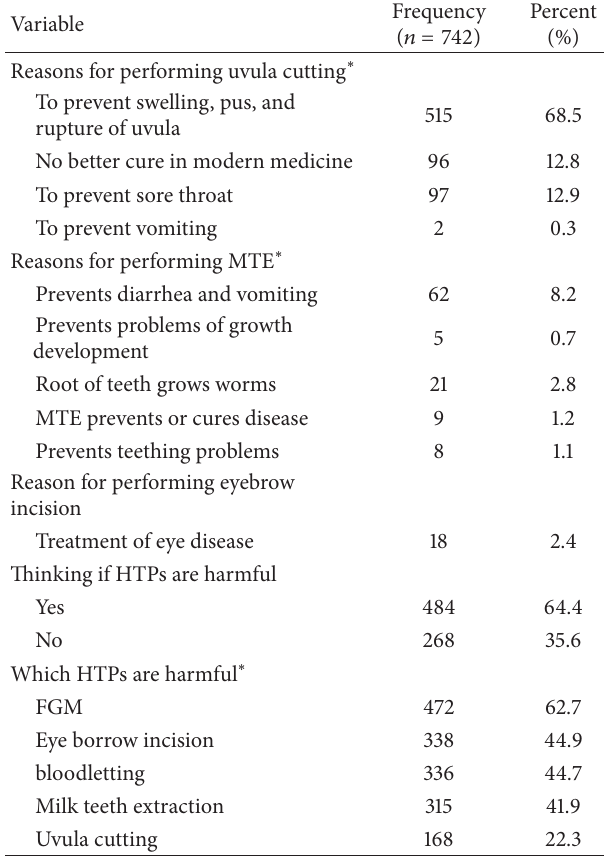
Table 3: Reasons associated with harmful traditional practices among children less the 5 years old in Axum Town, North Ethiopia,